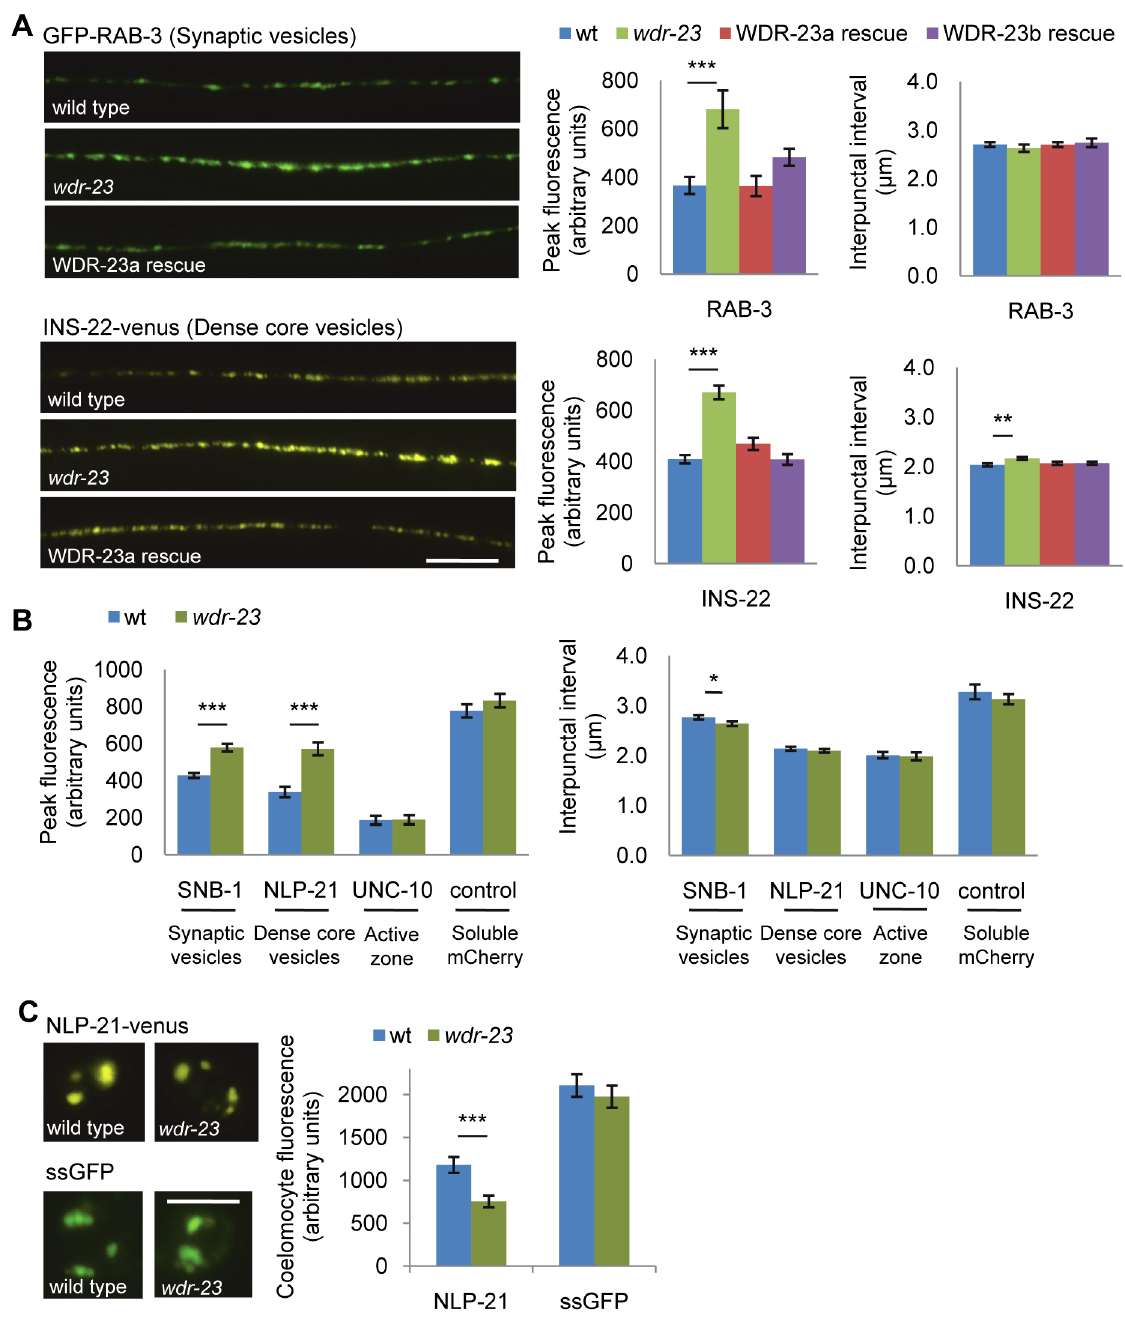
Figure 3. Synaptic vesicle and dense core vesicle secretion defects of wdr-23 mutants. (A) Left , Representative images of the distribution of the synaptic vesicle protein GFP-RAB-3 and the pro-neuropeptide INS-22-YFP driven by the unc-17 /VAChT promoter in cholinergic motor neurons in young adult wild type, wdr-23 mutants and rescued wdr-23 mutants expressing WDR-23a cDNA driven by the endogenous wdr-23 promoter and integrated via Mos insertion. Right , Quantification of the peak fluorescence and the interpunctal interval (Student’s t- test). (B) Quantification of the peak fluorescence ( left ) and interpunctal interval ( right ) of the synaptic vesicle associated protein GFP-SNB-1/synaptobrevin, the pro-neuropeptide protein NLP-21-YFP, and the active zone protein UNC-10/RIM1-GFP. Control refers to soluble mCherry expressed under the unc-17/ VAChT promoter. (C) Left , Representative images of coelomocyte fluorescence in wild type and wdr-23 L4 stage animals expressing NLP-21-YFP. Right , Quantification of NLP-21-YFP in coelomocytes of wild type and wdr-23 mutants. ssGFP refers to GFP tagged to signal sequence which results in a constitutively secreted version of GFP (Student’s t- test). (Scale bar represents 10 m m; Error bars indicate 6 SEM. * p , 0.05, ** p , 0.01, *** p , 0.001.) doi:10.1371/journal.pgen.1003354.g003 resistance in both wild type animals and nre-1 lin-15b mutants Next, we selectively knocked down wdr-23 activity in specific (Figure 4D), suggesting that wdr-23 activity is likely to be required tissues by expressing inverted repeat hairpin transgenes directed toward wdr-23 using tissue specific promoters (in a sid-1 mutant outside of the nervous system for its effects on aldicarb response.